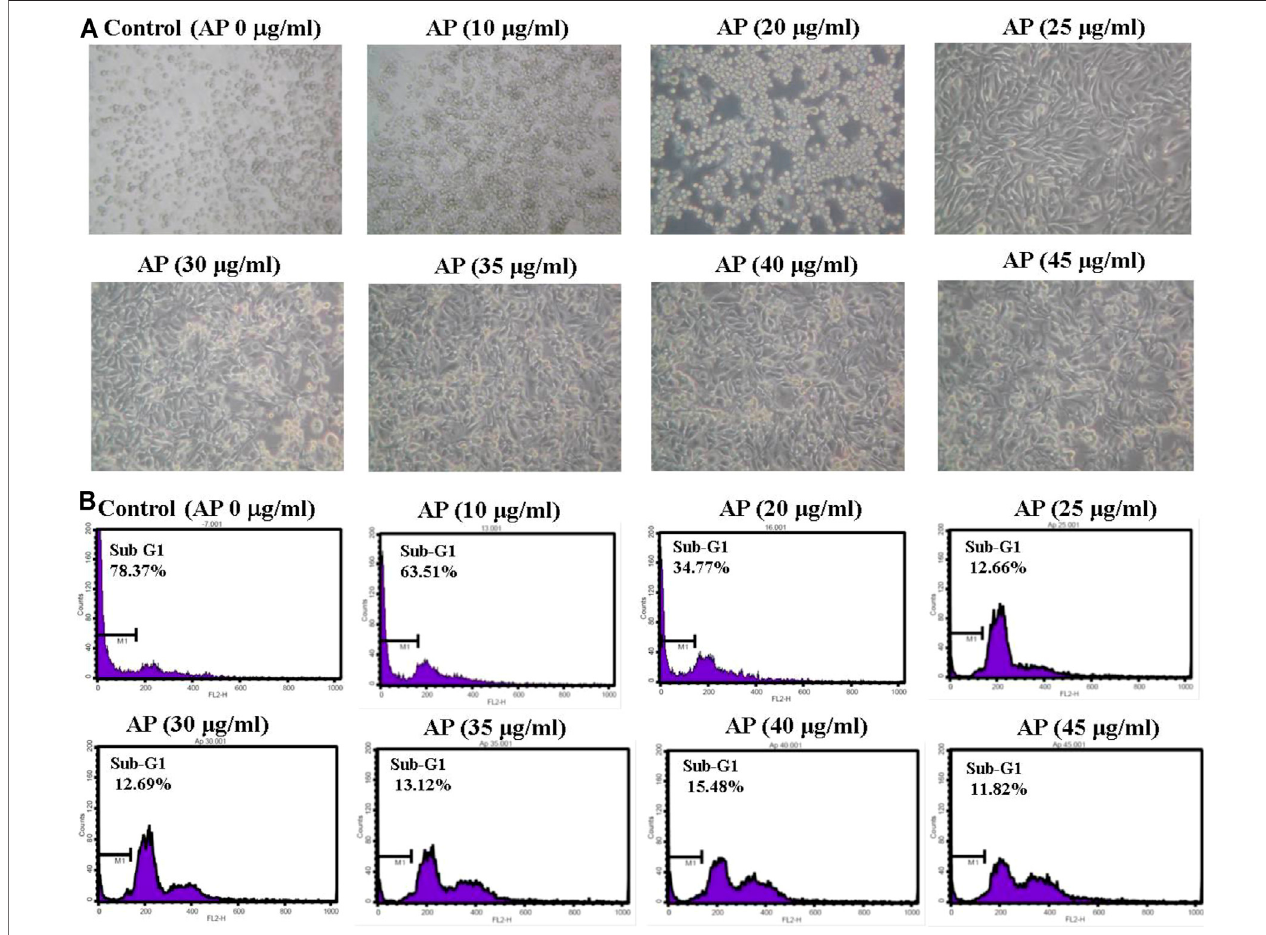
FIGURE 3 | EV71-induced cytopathic effects are inhibited by AP EtOAc extracts. (A) Morphological changes of RD cells observed under an inverted microscopy ( × 20). (B) Sub-G1 population of the infected RD cells was analyzed by fl ow cytometry illustrated as a histogram. Con fl uent monolayers of RD cells were pretreated with AP EtOAc extracts at the doses of 10, 20, 25, 30, 35, 40, or 45 μ g/ml for 2 h and then challenged with 10 − 7 of EV71 simultaneously at 37 ° C. The cytopathic effect was observedunderamicroscope( × 20)after48 h.Then,thecellsweretrypsinized,andsub-G1cellcyclearrestwasanalyzedin fl owcytometryafterbeingstainedwith PI. M1 indicates the sub-G1-gated region in the histogram. Data are representative of three independent experiments. All AP-treated results were signi fi cantly different from those of EV71 only analyzed by Student ’ s t -test (Supplementary Table S1) . EV71, enterovirus 71; AP, Andrographis paniculata ; EtOAc, ethyl acetate; RD, rhabdomyosarcoma; PI, propidium